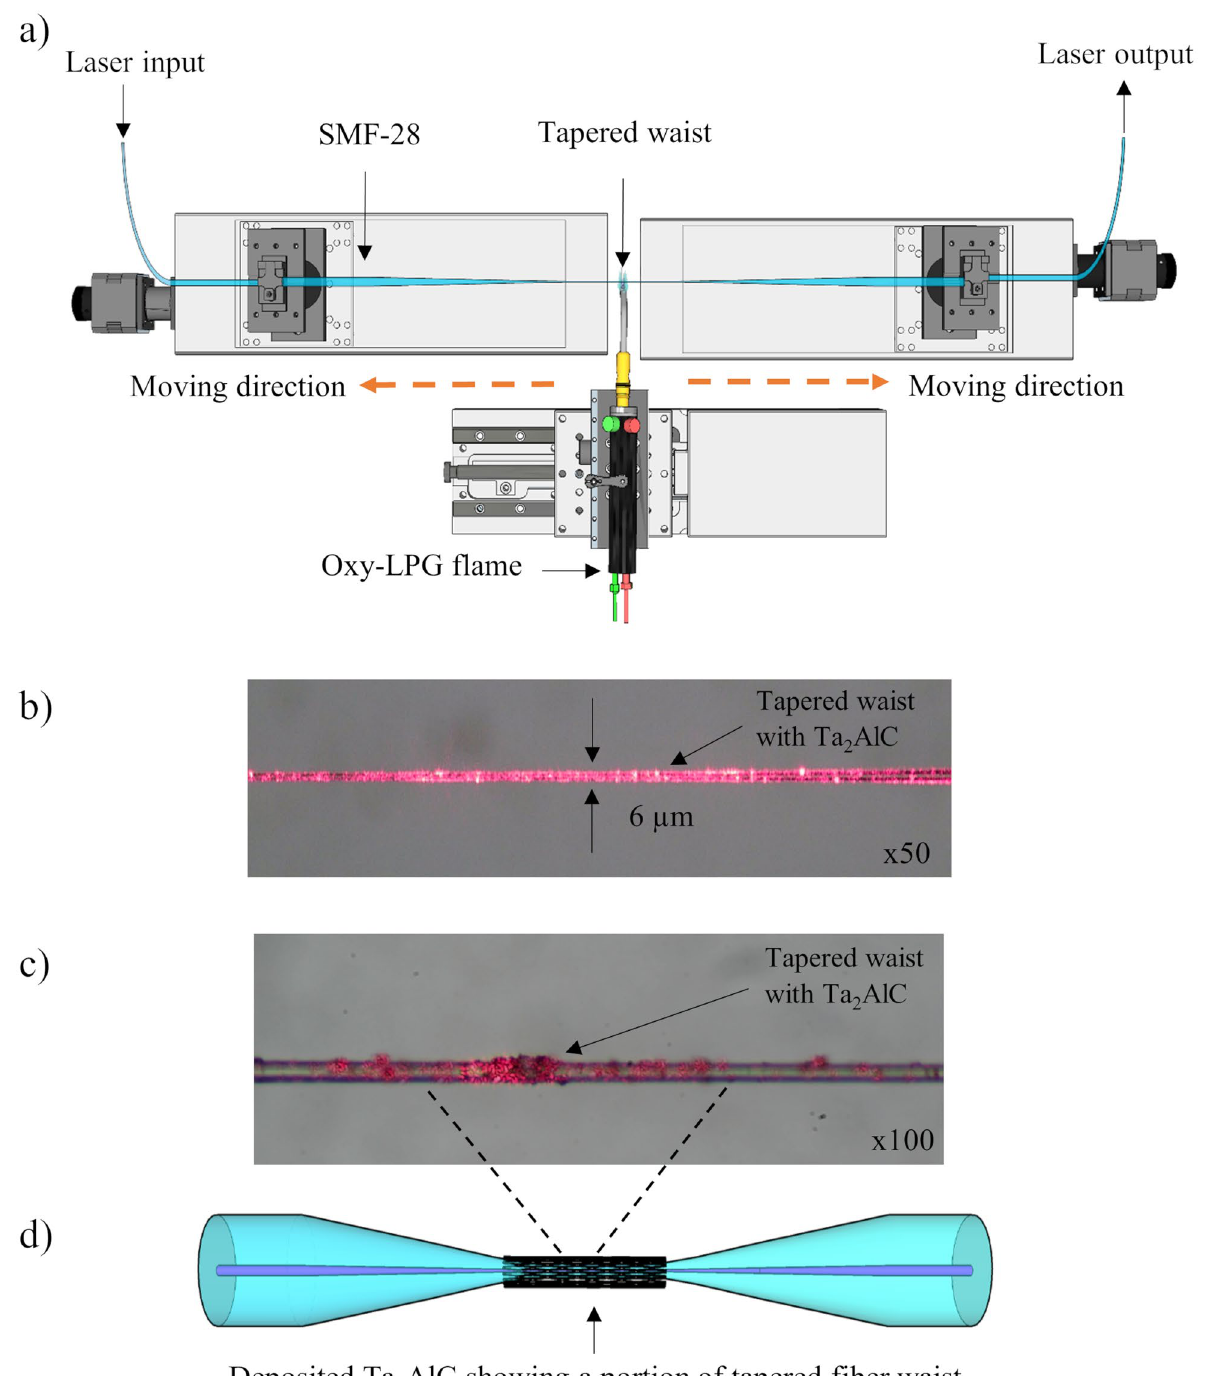
Figure 4. ( a ) The setup of flame brushing method to fabricate tapered fiber. ( b ) The microscopic image of the tapered fiber at ×50 and ( c ) ×100 magnification with the material. ( d ) The schematic drawing of the coated Ta 2 AlC tapered fiber ( a ) was drawn using SketchUp Make 2017 (Basic), Software Version: Windows 64-bit 17.2.2555. Available at https:// www. sketc hup. com/ downl oad/